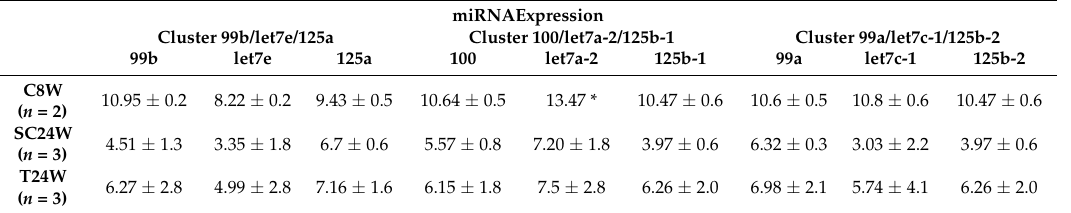
Table 1. Expression of the individual members of the murine miR-125a/miR-125b-1/miR-125b-2 gene clusters in ATH progression and after treatment with the specific anti-CD40 siRNA. The different miRNAs were tested by Taqman Low Density Array card (TLDAs) in the different experimental conditions stated [25], and individual expression values were normalized to U6 expression ( Δ Ct Gene-U6 snRNA) and expressed as mean ±SD of the different samples. C8W, control mice at 8 weeks. SC24W, mice treated with the scrambled control siRNA for 24 weeks (control group for ATH progression, see Materials and Methods). T24W, mice treated with the anti-CD40 siRNA for 24 weeks (treatment group). (*) Only one sample could be analyzed. miRNAExpression Cluster 99b/let7e/125a Cluster 100/let7a-2/125b-1 Cluster 99a/let7c-1/125b-2 99b